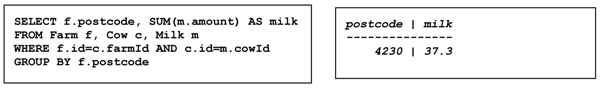
Query to compute total amount of milk for each postcode